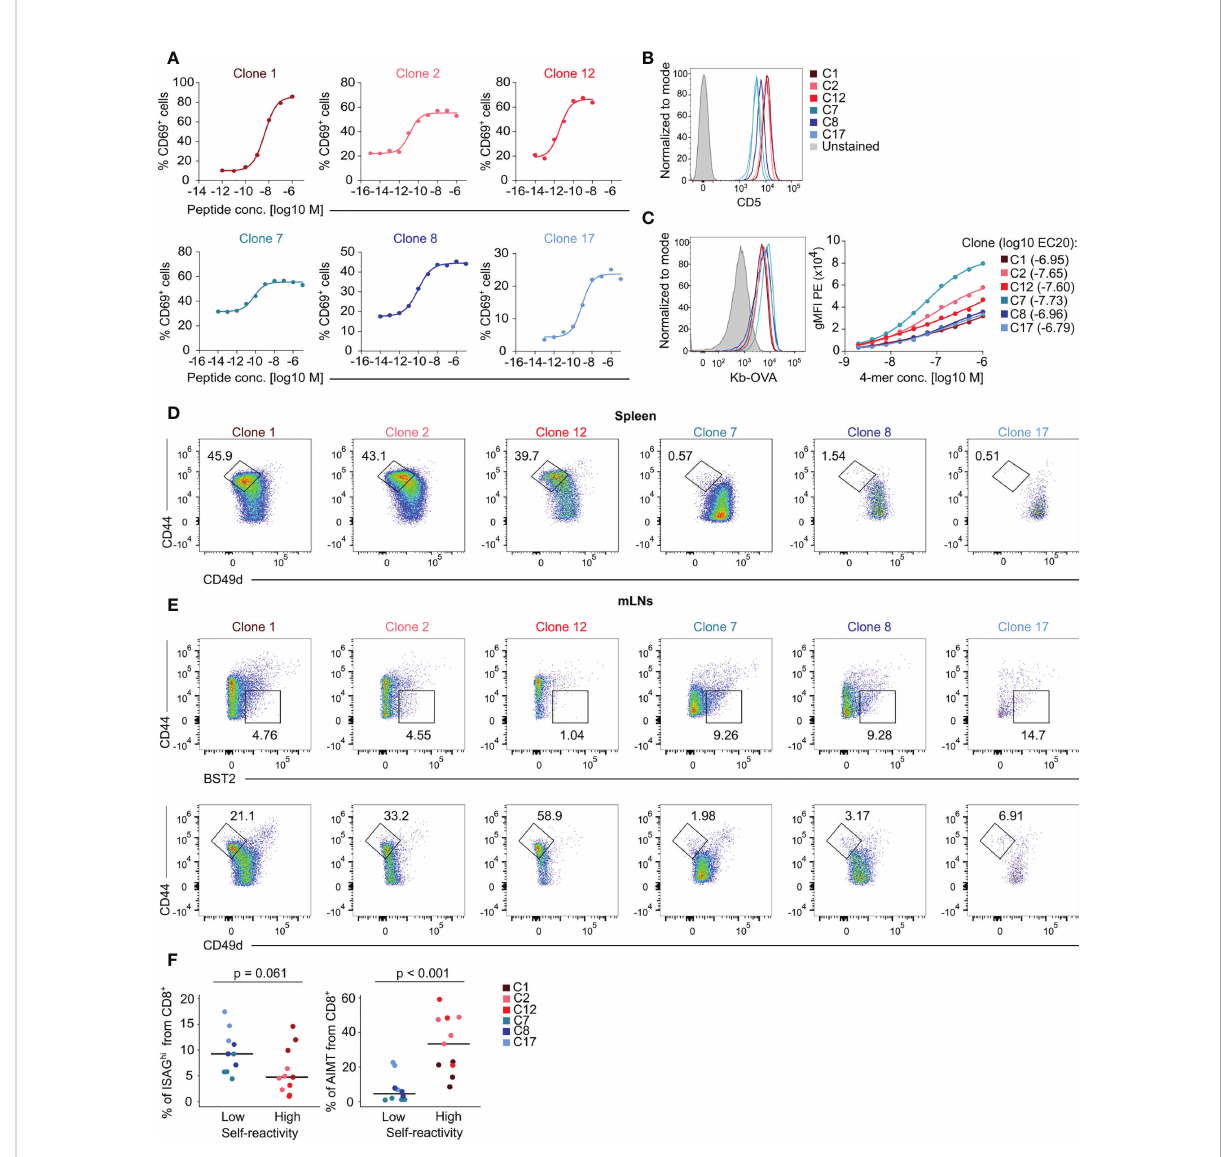
FIGURE 2 Characterization of the speci fi city, self-reactivity, and phenotype of a collection of monoclonal T cells. (A) Jurkat CD8 + OT-I TCR b cells expressing indicated TCR a clones were activated by T2-Kb cells loaded with indicated concentrations of OVA peptide overnight. The level of CD69 was measured by fl ow cytometry. Curves were fi t using nonlinear regression. (B – E) Peripheral lymphocytes were isolated from sub- lethally irradiated Ly5.1 mice transplanted with immortalized hematopoietic stem cells transduced with indicated clones and the recipient Ly5.2 CD8 + T cells were analyzed by fl ow cytometry. (B) Expression of the surface marker CD5 on LN T cells. A representative experiment out of three in total. (C) Left – staining of LN CD8 + T cells with fl uorescently labeled K b -OVA tetramer. A representative experiment out of three in total. Right – staining with a dilution series of fl uorescently labeled K b -OVA tetramer. Tetramer binding was measured by fl ow cytometry. Curves were fi t using nonlinear regression. Averages from three independent experiments. (D) Representative FACS plots showing the percentage of AIMT (CD44 high CD49d low ) T cells among CD8 + splenocytes from each clone. (E) Representative FACS plots of ISAG hi T cells (CD44 low BST2 + ) and AIMT cells (CD44 high CD49d low ) from each clone from mLNs. (F) Quanti fi cation of data from three